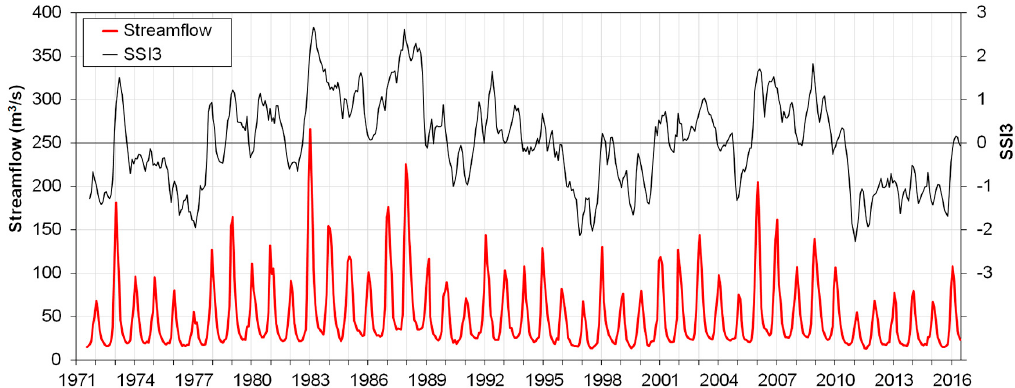
Figure 3. Temporal evolution of monthly streamflow (red line) and monthly SSI3 (black line) for the